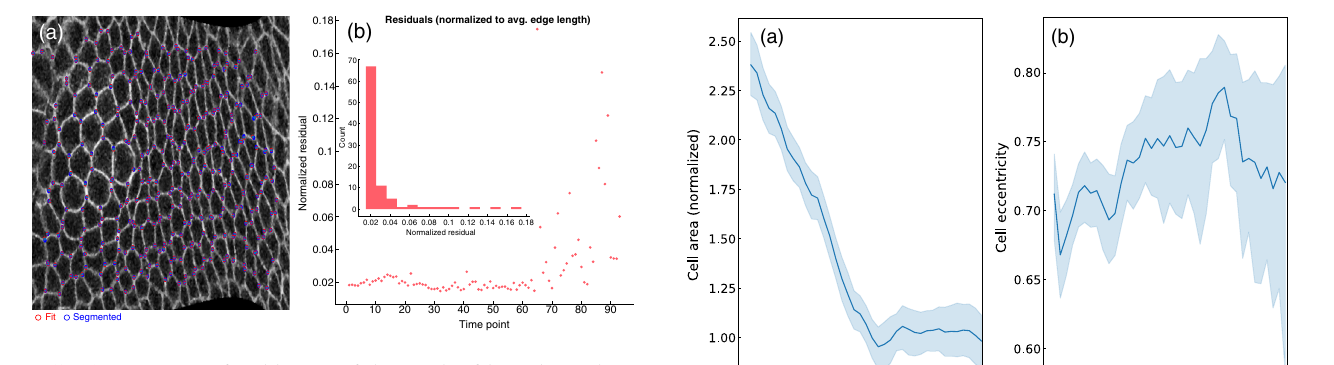
FIG. 12. (a) A confocal image of the patch of lateral ectoderm during GBE comparing vertex positions obtained by segmenta- tion (in blue) and the position obtained by VMSI (in red). (b) The plot of residual [Eq. (5)] normalized by the average bond length over the time course of the movie analyzed. The inset displays the distribution of values. The VMSI begins to make qualitative errors during the late stage GBE, in agreement with our observation that myosin becomes unbalanced.